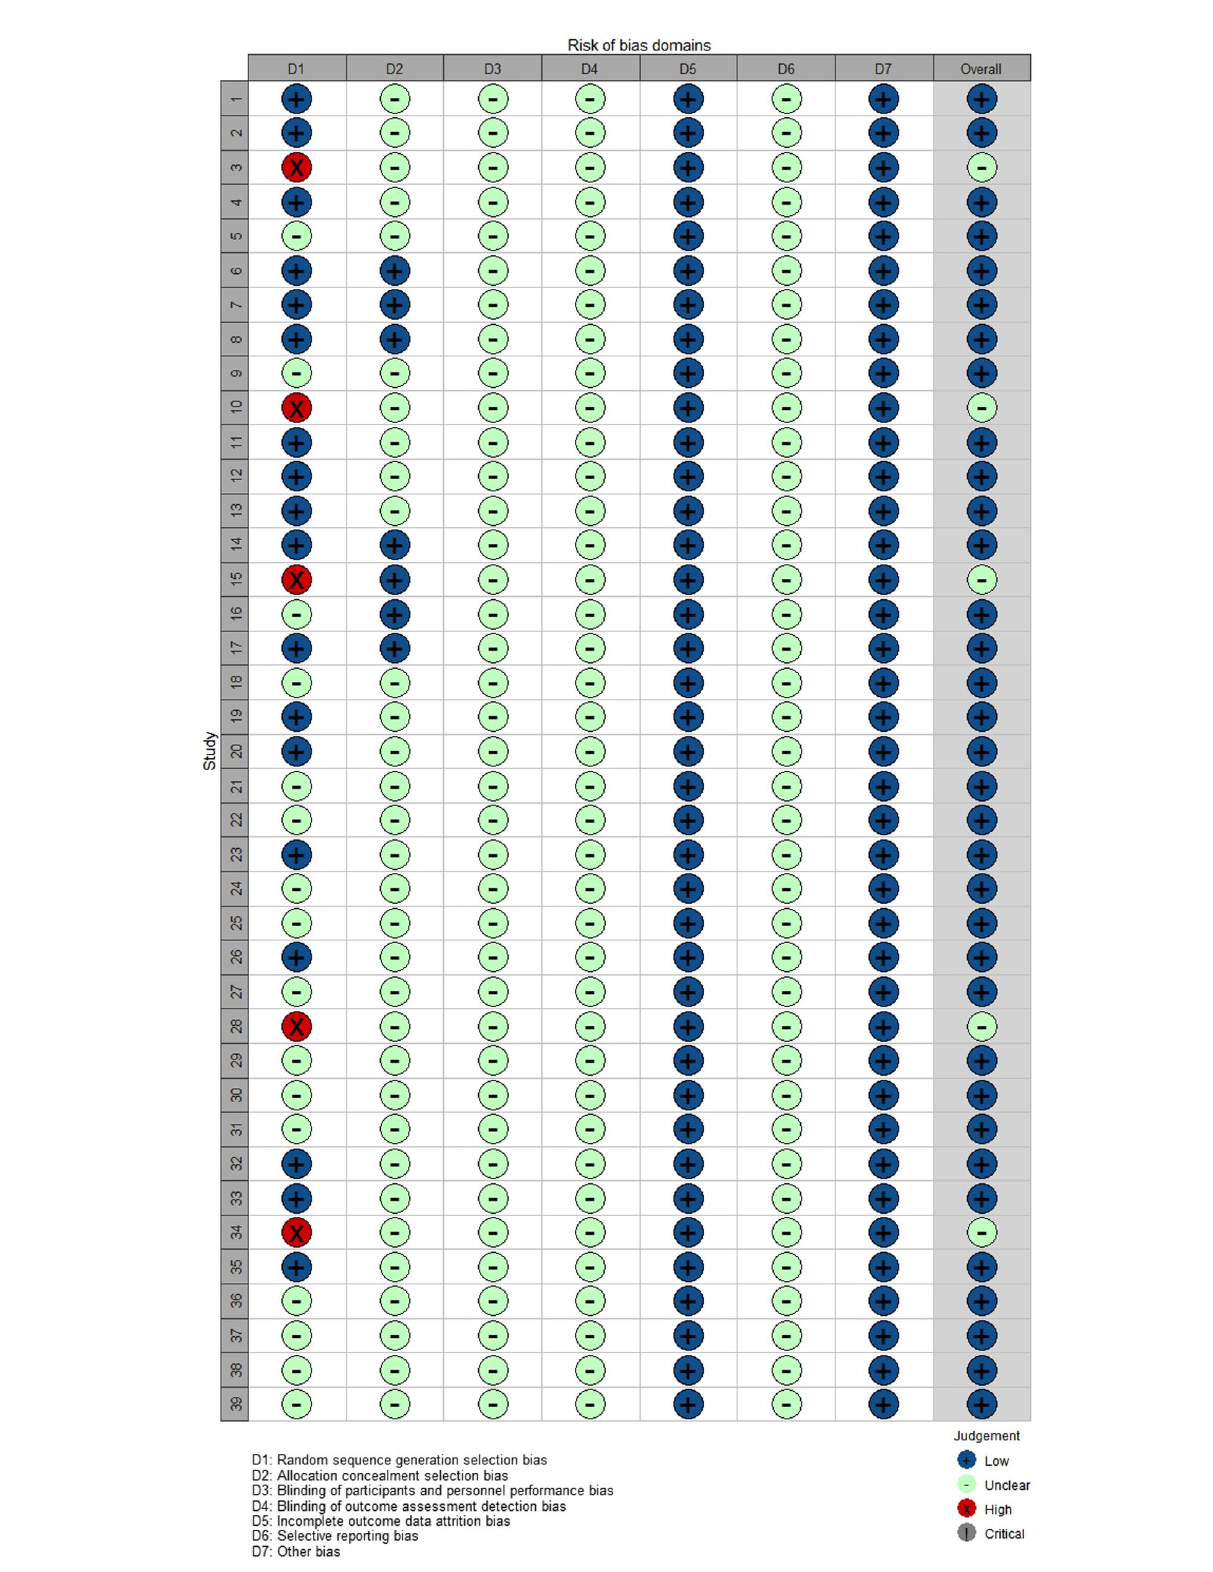
FIGURE 3 Risk of bias among included RCTs. Shuai Sun 2020 (1), Zhonghua Qin 2017 (2), Yiyi Zeng 2016 (3), Jinng Huang 2022 (4), Xueyuan Jiang 2009 (5), Lili Zhang 2021 (6), Wang Luo 2021 (7), Tao Xu 2014 (8), Xiaocheng Shi 2012 (9), Xiaowei Wei 2005 (10), Wei Wang 2019 (11), Ying Tang 2015 (12), Liping Cui 2021 (13), Lingzhi Wu 2018 (14), Wenqing Zou 2011 (15), Yan Li 2021 (16), Xiaoshu Xie 2021 (17), Qiang Li 2019 (18), Qinghua Zhu 2022 (19), Lingzhe Li 2021 (20), Kaipeng Liang 2016 (21), Zusen Guo 2014 (22), Yu Xia 2022 (23), Lanzhi Huang 2019 (24), Liping Shen 2019 (25), Yulin Chen 2016 (26), Lezhong He 2012 (27), Ning Xu 2005 (28), Aiqun Mo 2018 (29), Xijuan Zhang 2015 (30), Chaying Hu 2022 (31), Yan Zhang 2019 (32), Wei Ni 2017 (33), Dongwei Sun 2005 (34), Haisheng Wu 2021 (35), Tianhong Hu 2018 (36), Xiong Qian 2017 (37), Jianxi Wang 2013 (38), and Donglan Ye 2013